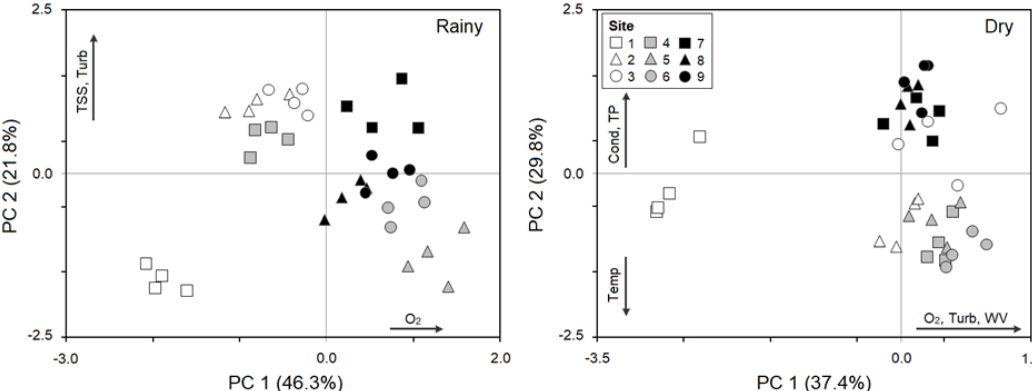
Figure 3. Principal component analysis (PCA) ordination showing the environmental differences for each site in the Aporé River, Paranaíba River basin, during the different hydrological seasons. Abbreviations: Cond, electrical conductivity; O , dissolved oxygen; Temp, temperature; TP, total phosphorus; TSS, total suspended solids; Turb, 2 turbidity; WV, water flow